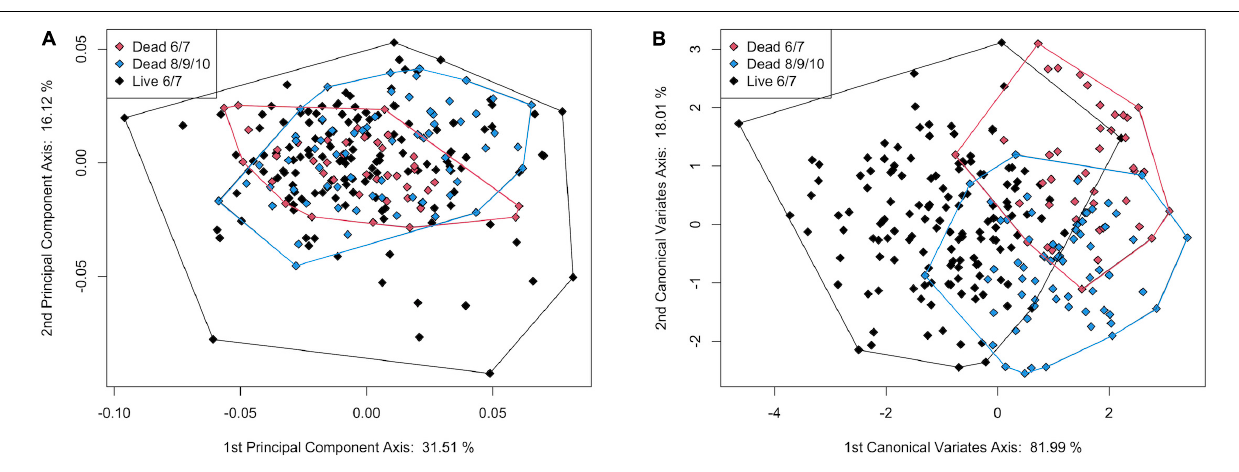
FIGURE 10 | Plot of (A) principal component axis 1 vs. principal component axis 2 and (B) canonical variate axis 1 vs. canonical variate axis 2 for the 3-group comparison of live and dead S. floridana